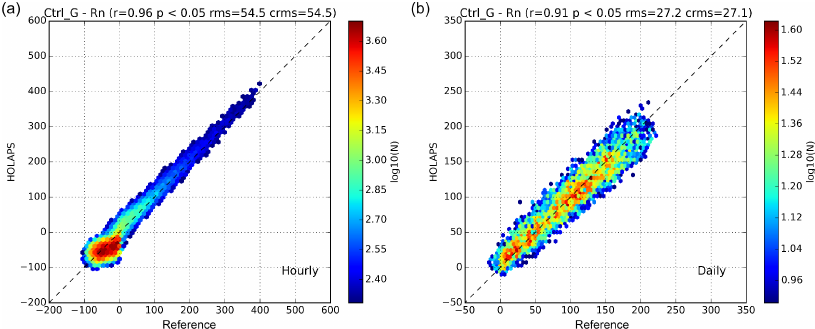
Figure 4. Comparison of surface net radiation flux ( R N ) between FLUXNET measurements and HOLAPS estimates for the CTRL experi- ment: (a) hourly and (b) daily timescales. Colors indicate the frequency of occurrence of values (data density). Units in Wm − 2 .